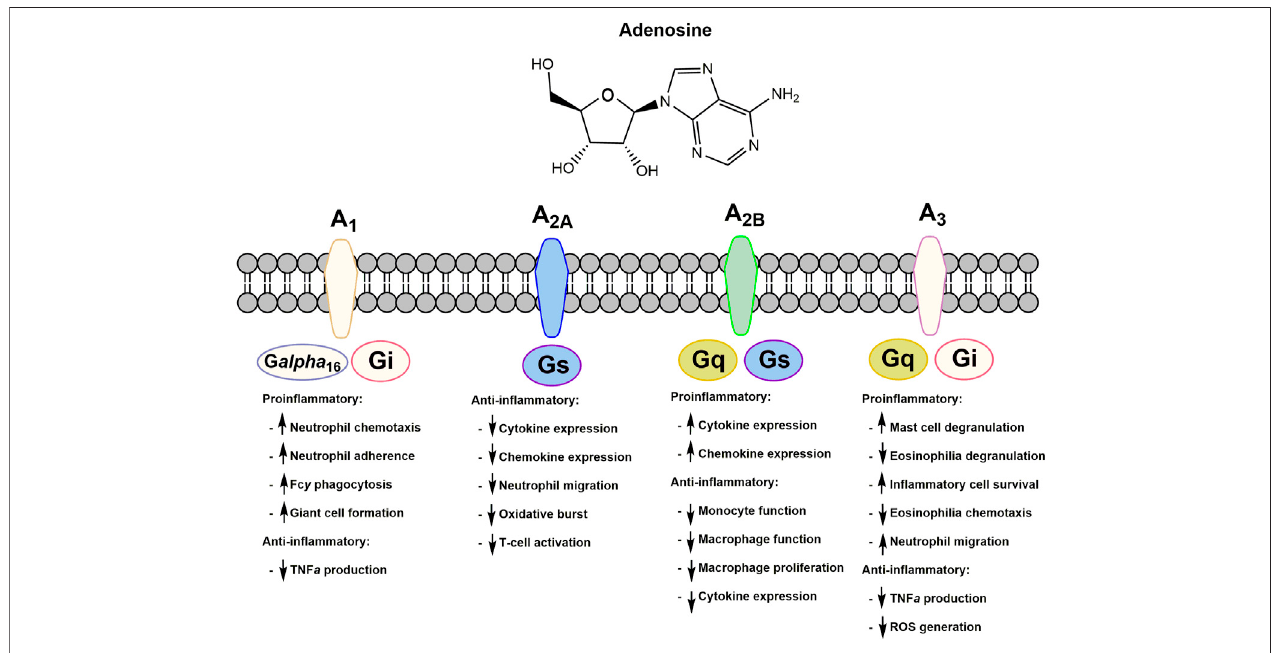
FIGURE 3 | Adenosine receptors and their respective proin fl ammatory and anti-in fl ammatory responses upon extracellular adenosine binding. All adenosine receptors are a part of the G-protein coupled receptor family. Respective G-protein signaling partners are indicated on each subtype of adenosine receptor.